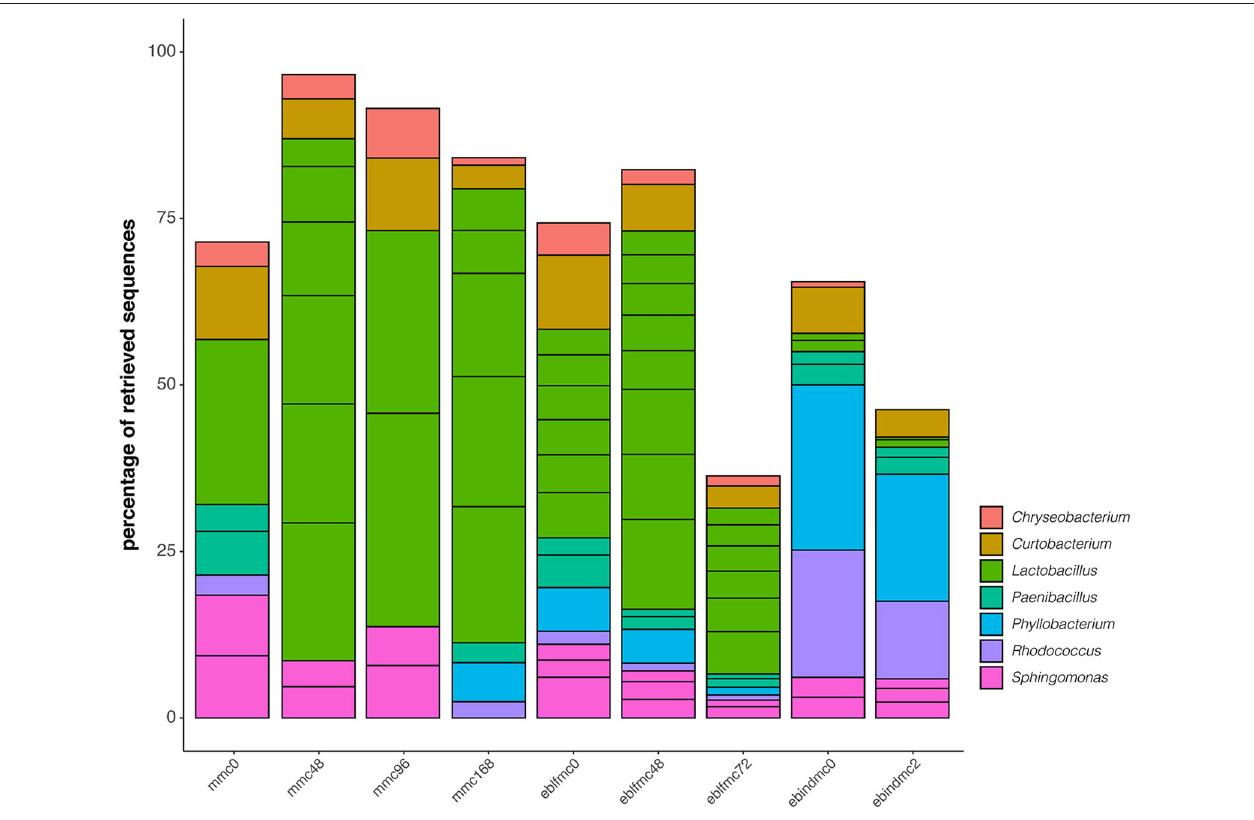
FIGURE 3 | Phylogenetic diversity of the first 20 most abundant ASVs for bacteria (16S rRNA gene) recovered from the massive sequencing analysis of the different types of bread doughs (MMC, sourdough; eblfmc, Elias–Boulanger long-fermentation raw dough; ebindmc, Elias–Boulanger industrial raw dough) at different times of